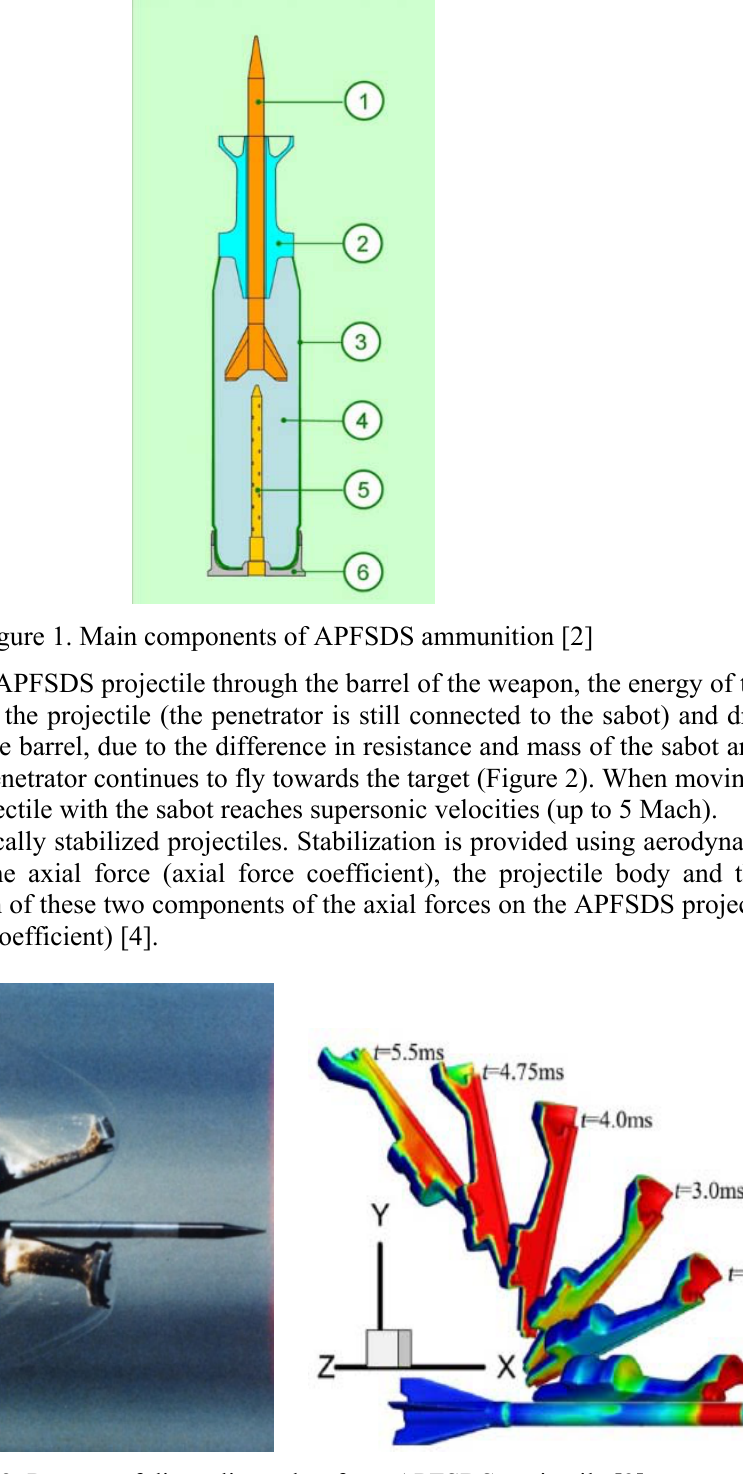
Figure 2. Process of discarding sabot from APFSDS projectile